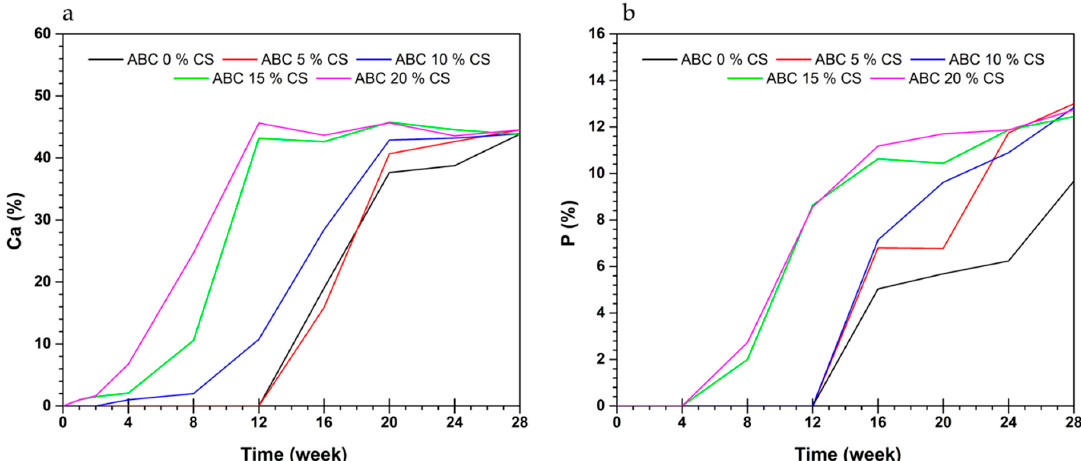
Figure 8. Content of ( a ) Ca and ( b ) P by EDS analysis of the surfaces of ABCs loaded with CS after different times of soaking in SFB.